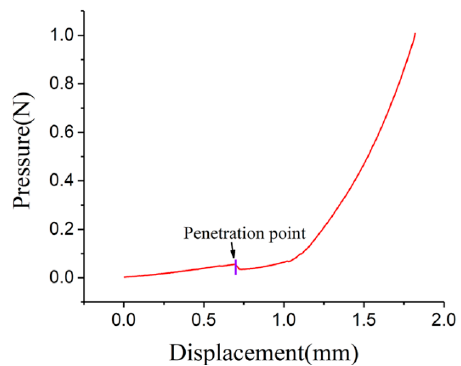
Figure 7. The pressure-displacement curve of artificial skin penetration.